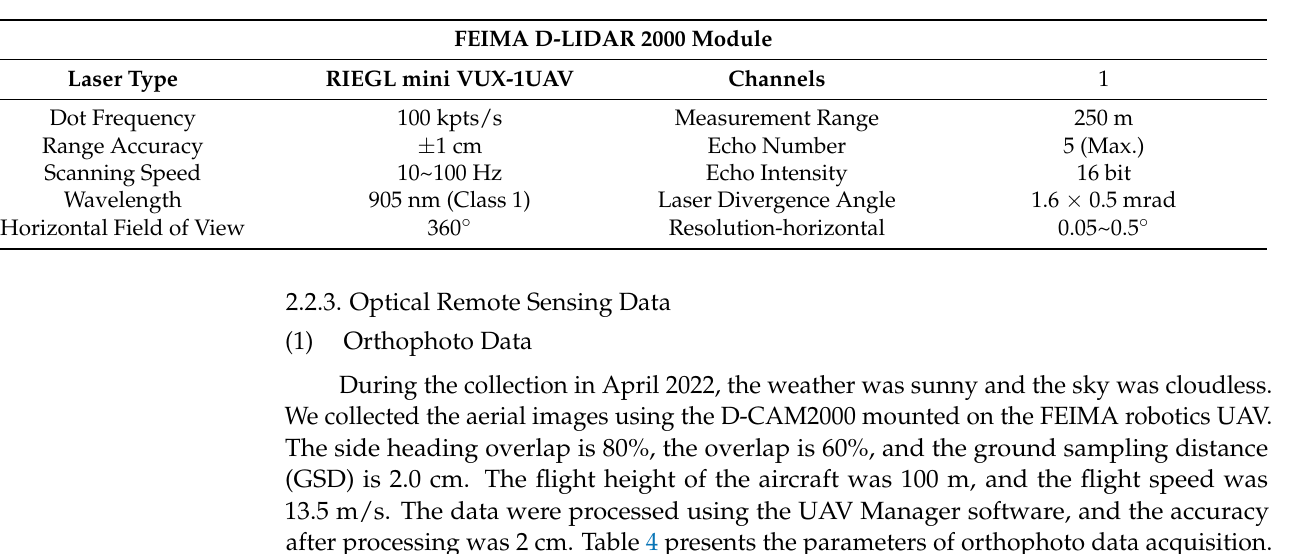
Table 3. Parameters of LIDAR data acquisition.